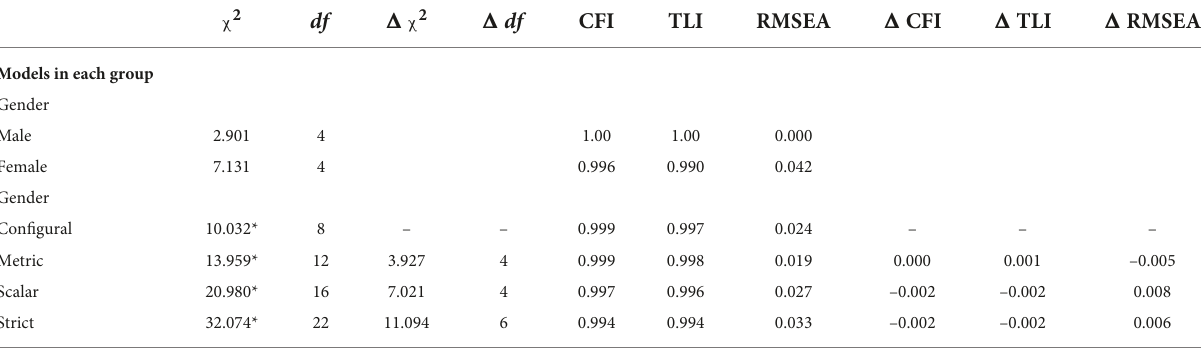
TABLE 4 Tested models and goodness-of-fit indices.